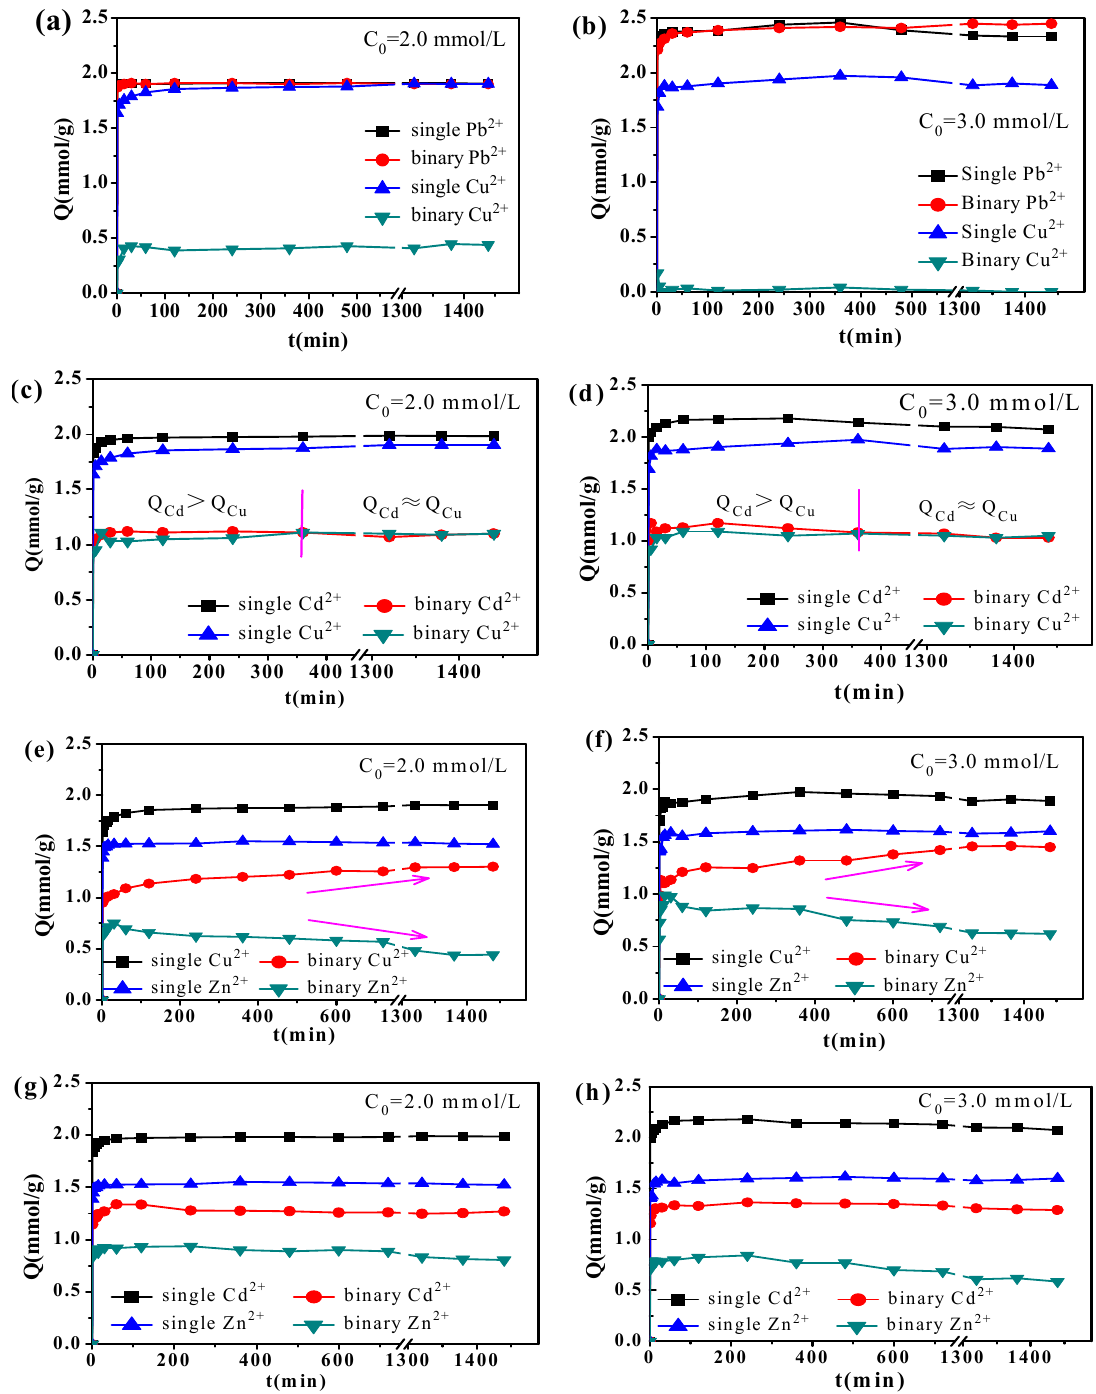
Figure 4. Time profiles of heavy metals adsorption in binary systems using NaX at equal molar ratio: Cu 2+ -Pb 2+ binary system ( a , b ), Cu 2+ -Cd 2+ binary system ( c , d ), Cu 2+ -Zn 2+ binary system ( e , f ), and Cd 2+ -Zn 2+ binary system ( g , h ). Heavy metals that displayed small hydration energies were easier to dehydrate and subsequently be adsorbed by the NaX. However, in multiple ion systems, those ions